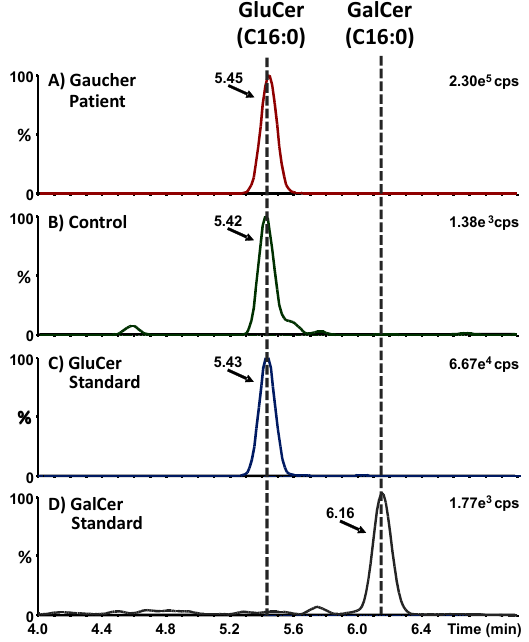
Figure 2. Multiple reaction monitoring (MRM) analysis of GluCer(C16:0) and GalCer(C16:0) ( m/z 700.57 > 264.27) in ( A ) vitrectomy fluid from the Gaucher type 3 patient; ( B ) vitrectomy fluid from a control; ( C ) commercial standard mixture of GluCer isoforms; and ( D ) commercial standard mixture of GalCer isoforms. Dotted lines correspond to mean retention times for GluCer(C16:0) and GalCer(16:0). Cps, counts per second.